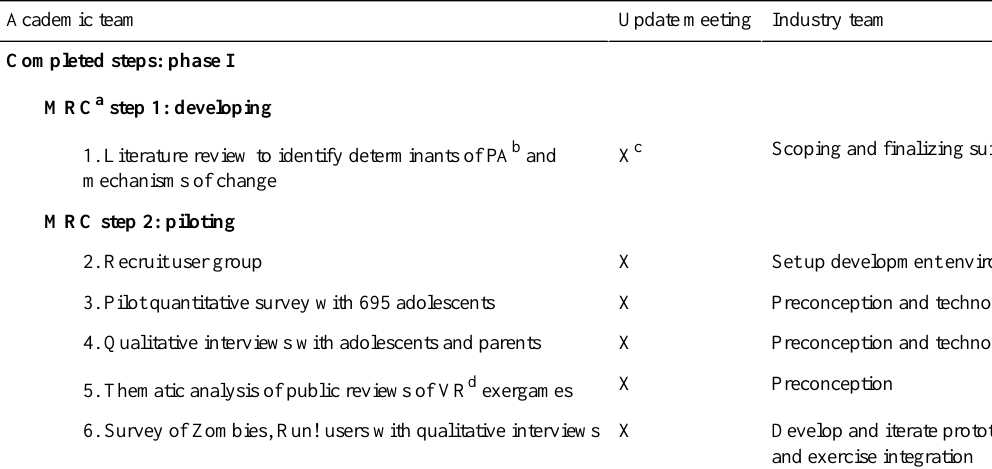
Table 1. Steps in phase I vEngage intervention development